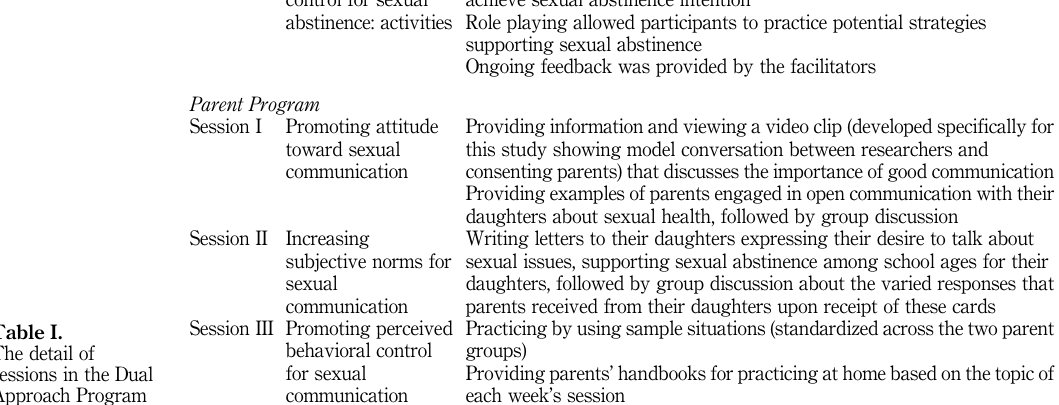
sessions in the Dual Approach